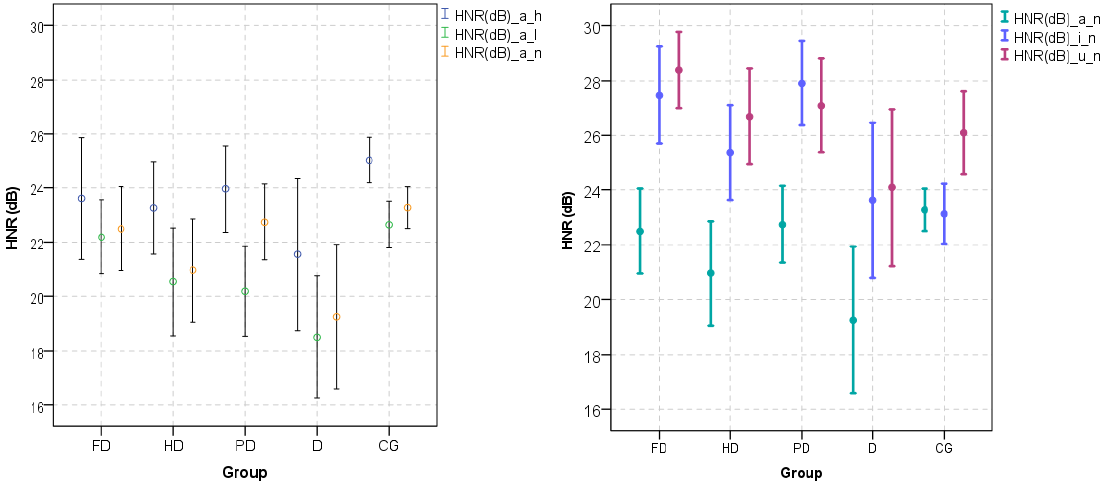
Figure 1. HNR along tones (h—high, l—low, n—neutral) for vowel /a/ (left-hand side), and along vowels (/a/, /i/, /u/) for neutral tone (right-hand side) for dysphonic and control voices. Groups are FD—Functional Dysphonia, HD—Hyperfunctional Dysphonia, PD—Psychogenic Dysphonia, D—Dysphonia and CG—Control Group. Bars represent the mean value ± standard deviation (95% confidence interval). (Adapted and with the courtesy of [25].)